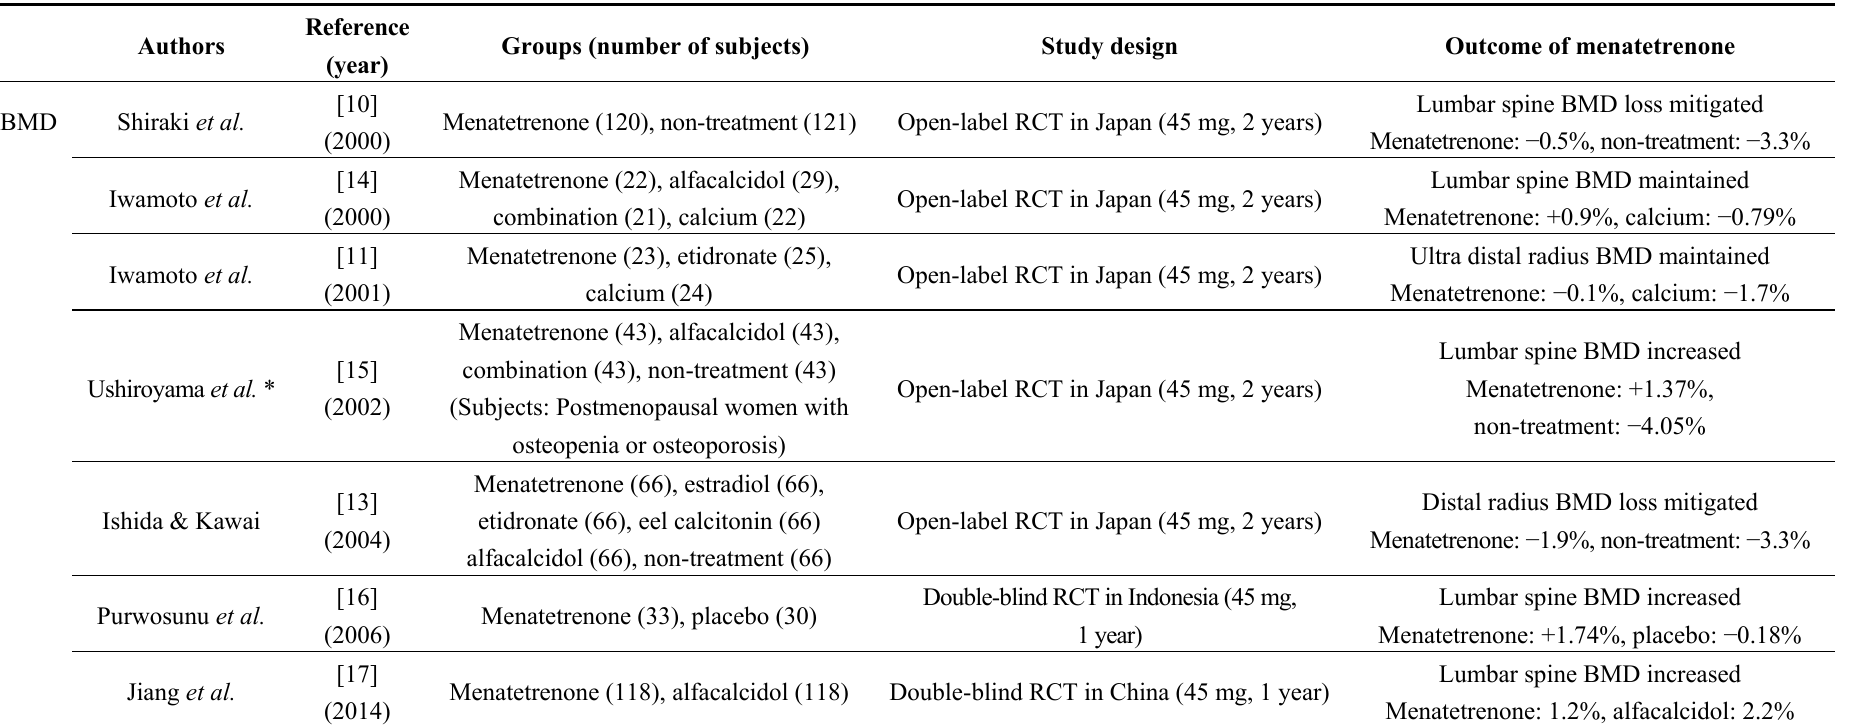
Table 1. Effects of menatetrenone on bone mineral density (BMD) and fracture incidence in postmenopausal women with osteoporosis: Randomized controlled